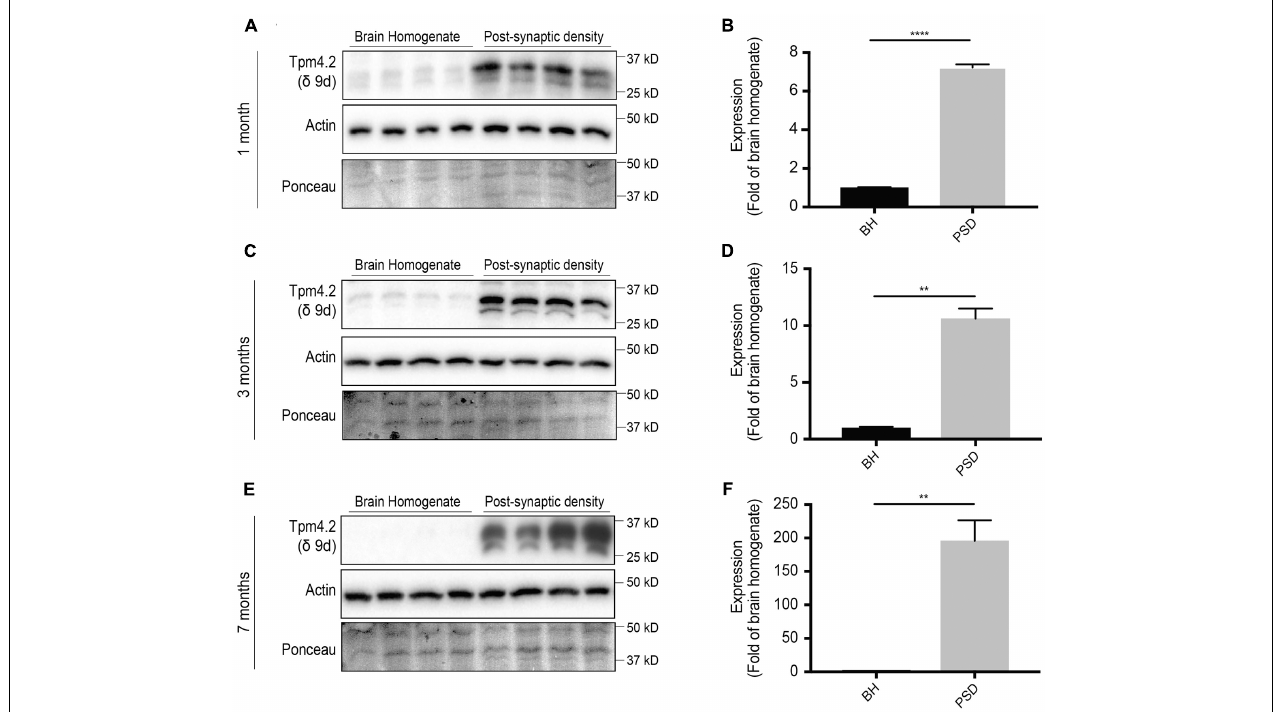
FIGURE 4 | Western blot expression profile of tropomyosin (Tpm) isoform Tpm4.2 (utilizing the δ 9d antibody) in the brain homogenate (BH) and post-synaptic density (PSD) of wild type mouse brains. (A) Western blot analysis of 1-month-old brain homogenate and PSD fractions. (B) Quantification of (A) normalized to expression in the brain homogenate. (C) Western blots of 3-months-old brain homogenate and PSD fractions. (D) Quantification of (C) normalized to expression in the brain homogenate. (E) Western blot of 7-months-old brain homogenate and PSD fractions. (F) Quantification of (E) normalized to expression in the brain homogenate. Total actin and Ponceau staining are used as loading controls. (mean ± SEM, n = 4, ∗∗ P < 0.01, ∗∗∗∗ P <